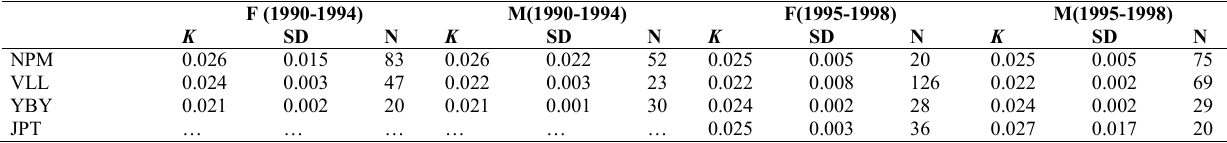
Table 4 . Average values of condition factor ( K ) of L. acutidens per site, sex and period of study. n = number of individuals, SD = standard deviation, F = females, M = males, N = sampling size, VLL = Puerto Valle, JPT = Puerto Júpiter, NPM = Nemesio Parma, YBY = Yabebiry.